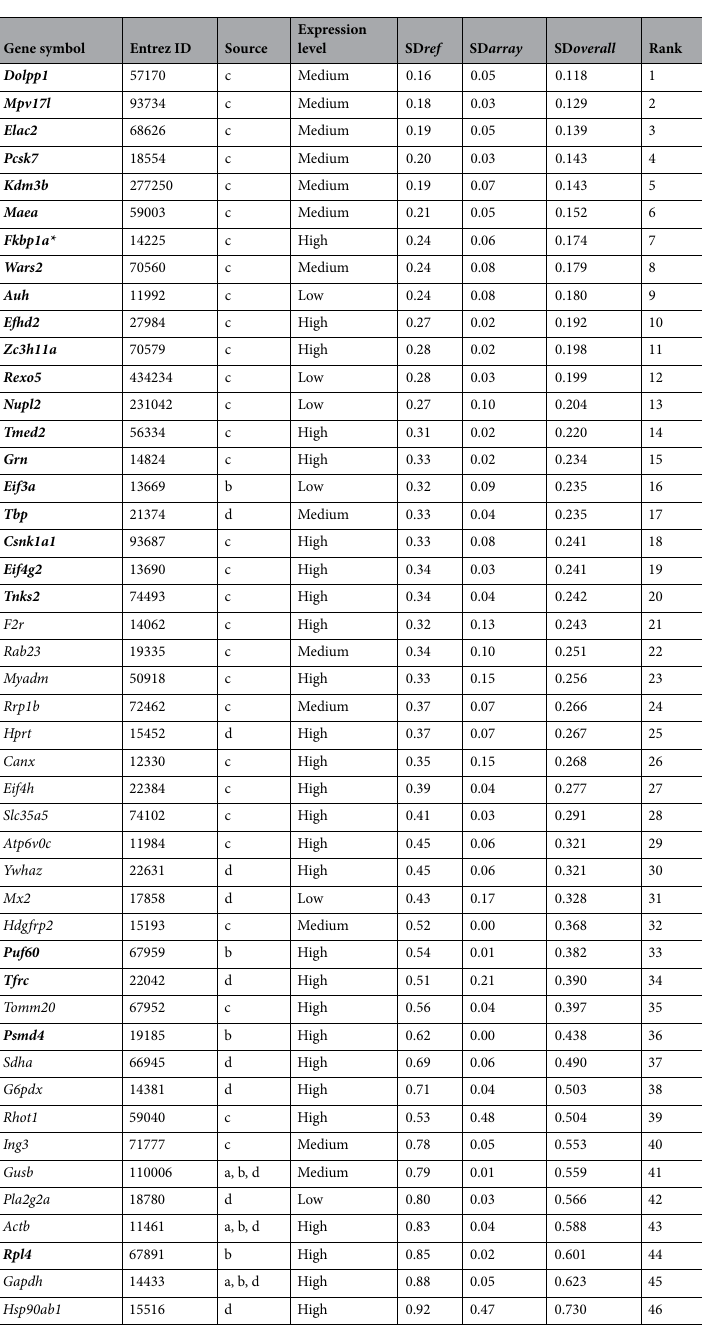
Table 1. The 24 final reference gene candidates. After the exclusion of 27 genes according to the criteria outlined in the text and subsequent confirmation of gene expression in our own transcriptomic data, 46 out of 122 reference gene candidates, shown in the table, remained for further analysis. Next, these 46 genes were ranked according to the overall SD covering both microarray data from our own and Genevestigator. The top 20 candidates with lowest overall SD and four additional genes chosen randomly from the rank 21–46 were selected for validation in neonatal murine lungs by RT-qPCR. Finally, it resulted in the 24 final reference gene candidates (highlighted in bold letters): four genes from reference gene studies, 18 genes from Genevestigator and two genes from the Roche commercial panel. * Fkbp1a was later excluded from further raw data analysis due to its undetectable low expression levels in several RNA samples. Gene expression levels are represented as log2-scaled signal intensity according to Genevestigator analysis: > 13.00 for high level, 10.00–13.00 for medium level, < 10.00 for low level. SDref stands for the SD from RefGenes analysis of Genevestigator and SDarray for the SD from our own microarray data. The overall SD was calculated by averaging SDref and SDarray. The source a for commonly used reference gene, b for reference gene study, c for Genevestigator and d for Roche reference gene